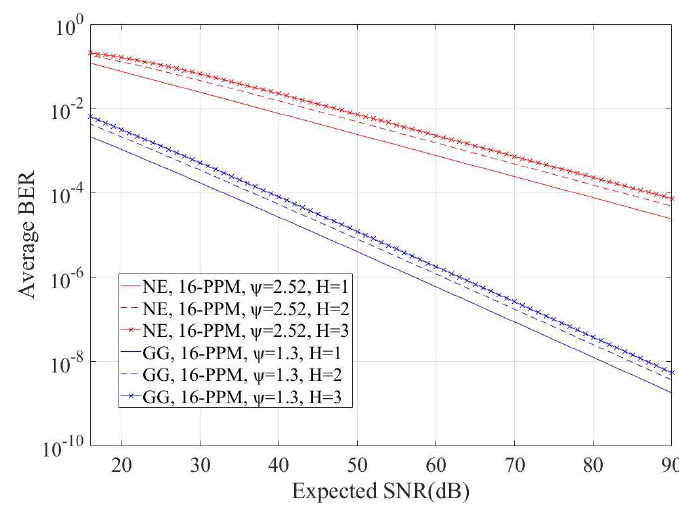
Figure 4. ABER of16-PPM scheme versus the expected SNR.